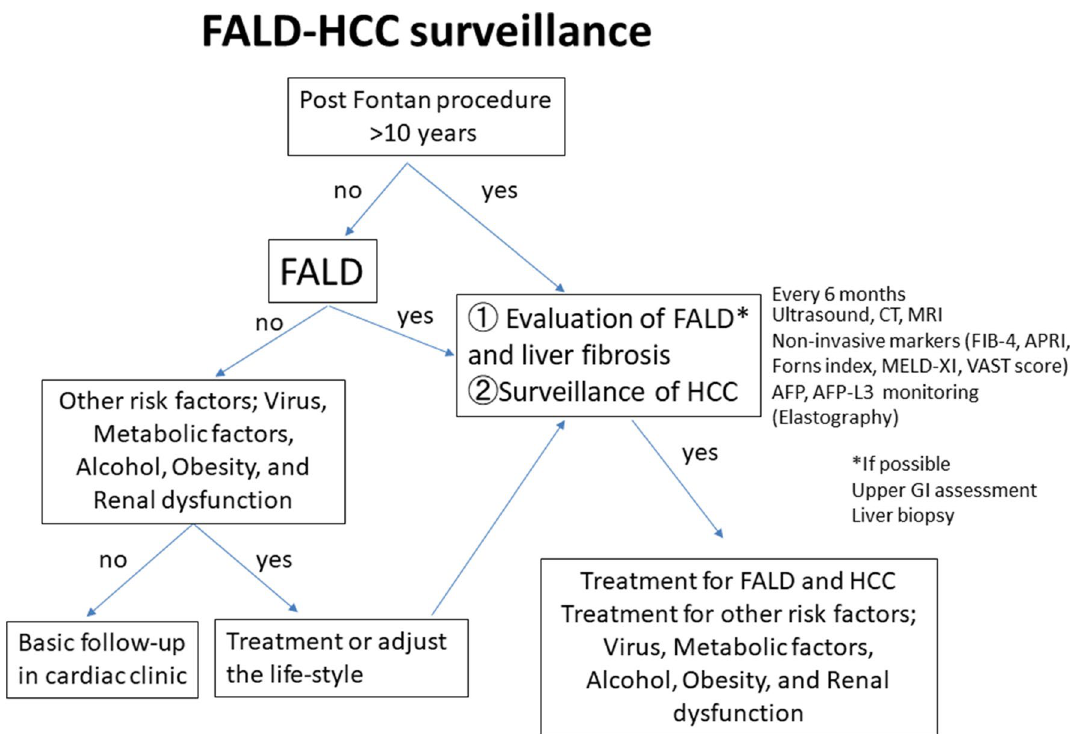
Figure 5. The algorithm for FALD-HCC surveillance. AFP, alpha fetoprotein, APRI, aspartate aminotransferase -to-platelet ratio index; CT, computed tomography; FIB-4, Fibrosis-4; FALD, Fontan-associated liver disease; GI, gastrointestinal; HCC, hepatocellular carcinoma; MELD, model for end-stage liver disease; MRI, magnetic resonance imaging, VAST score, varices, ascites, splenomegaly,